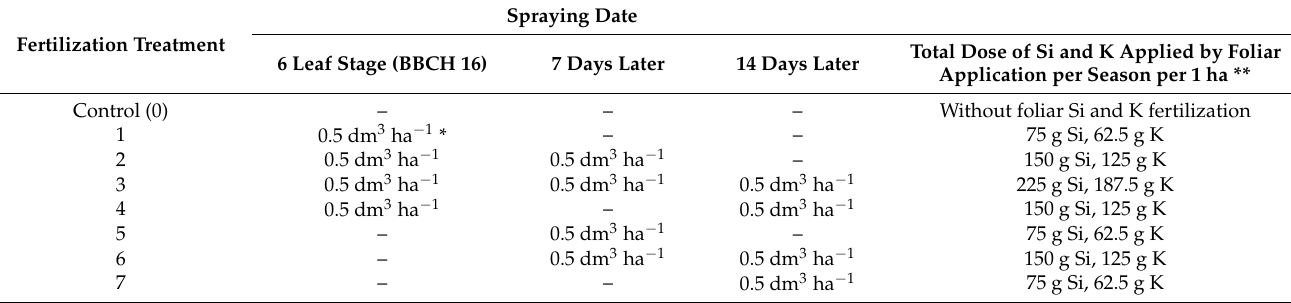
Table 8. Description of the studied fertilization